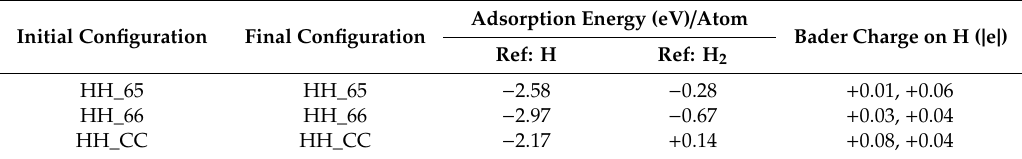
Table 3. Initial and final configurations of two single H atoms adsorbed on the surface of pristine C 60 , adsorption energies with respect to gas phase hydrogen atom and Bader charges on the H atoms.